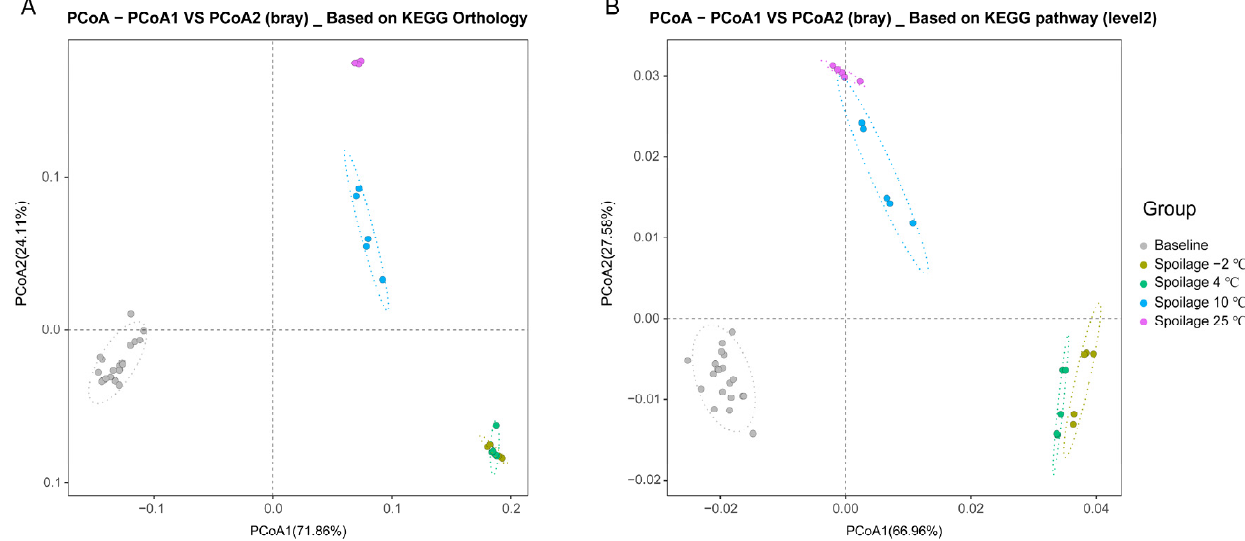
Figure 3. PCoA analysis of the functional potential of microbial communities. ( A ) PCoA analysis using the Bray–Curtis dissimilarity based on the KEGG Orthology. ( B ) PCoA analysis using the Bray–Curtis dissimilarity based on KEGG pathways (level 2).